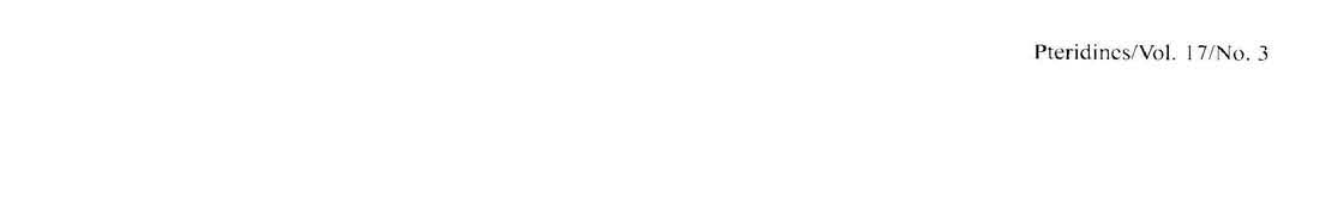
Figure 6. Influence of methotrexate (MTX) on the reductive effect of sepiapterin (SP) on the micronucle- us (MN) frequency induced by 5 Gy γ-rays in RAW264.7 cells. RAW264.7 cells were incubated with 1 mM sepiapterin for 18 h in the presence or absence of MTX and then irradiated. After irradiation, the cells were kept for 24 h under normal growth con- ditions before the quantification of micronuclei. Each point indicates the mean ± SE (n=500). The relative MN frequency was calculated with respect to the MN frequency of the group irradiated with 5 Gy γ-rays alone, taken as 100% at caeh time. * and ***, signifi- cantly different from the radiation-alone control at p<0.05 and p<0.005, respectively. ###. significantly different from the SP-treated group at p<0.005.